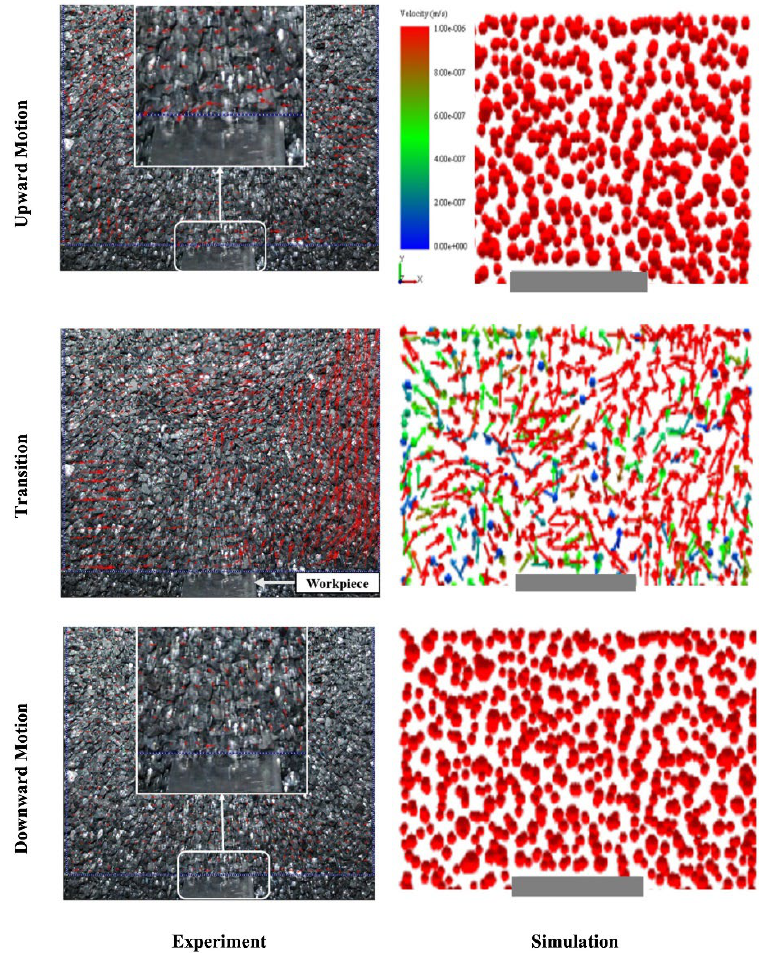
Figure 27. Workpiece position in the computational domain [165].